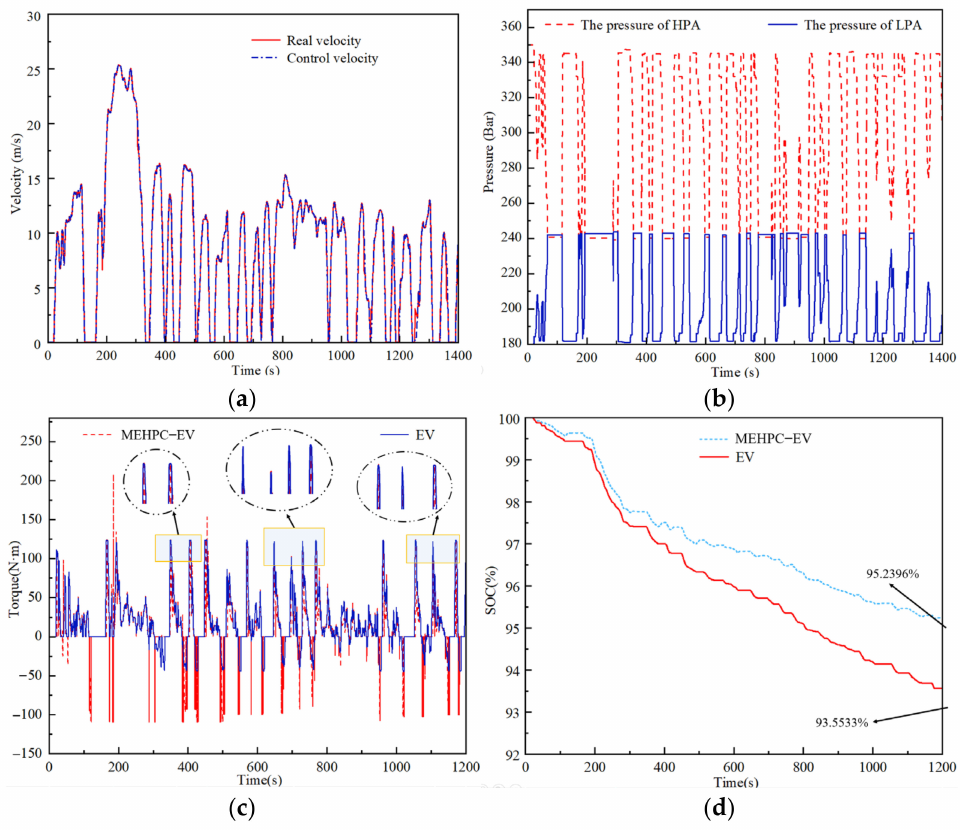
Figure 11. Diagram of MEHPC-EV simulation analysis. ( a ) is the speed curve, ( b ) is the accumulator pressure curve, ( c ) is the motor torque curve, and ( d ) is the battery SOC consumption rate